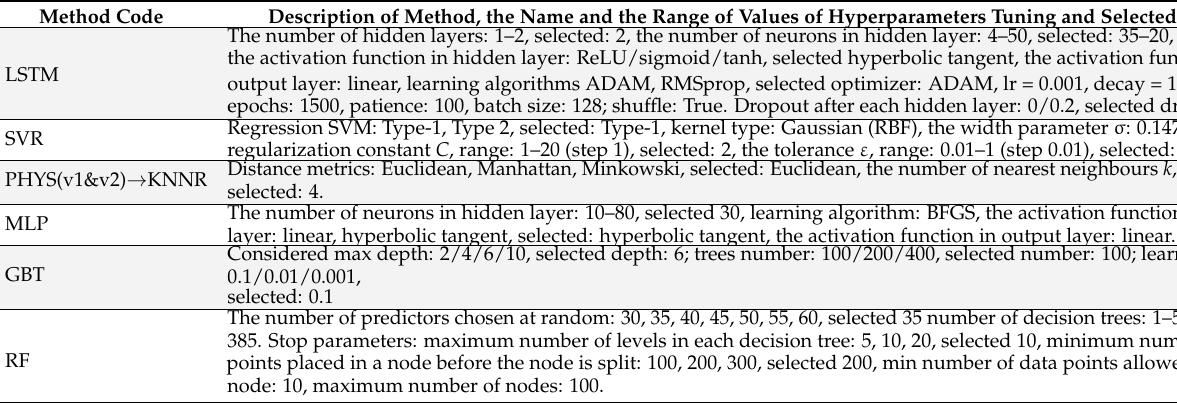
Table A1. The results of hyperparameters tuning for chosen single, hybrid and ensemble methods for Wind Farm